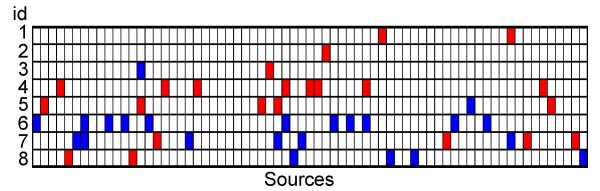
Sources enrichment analysis. The pattern of each of the sources enrichment for each of eight gene sets expressed exactly in two tissues (see additional file 10: Table S7) was calculated based on the significance (p < 0.07) of each of the source enrichments in each set. Blue and red squares indicate over or under representation of source in set, respectively (see additional file 9: Table S6). Ids indicate co-expression in: 1. Brain and Muscle; 2. Brain and Pancreases; 3. Brain and Prostate gland; 4. Brain and Thymus; 5. Lung and Kidney; 6. Lung and Spleen; 7. Muscle and Bone-Marrow; 8. Pancreases and Muscle.